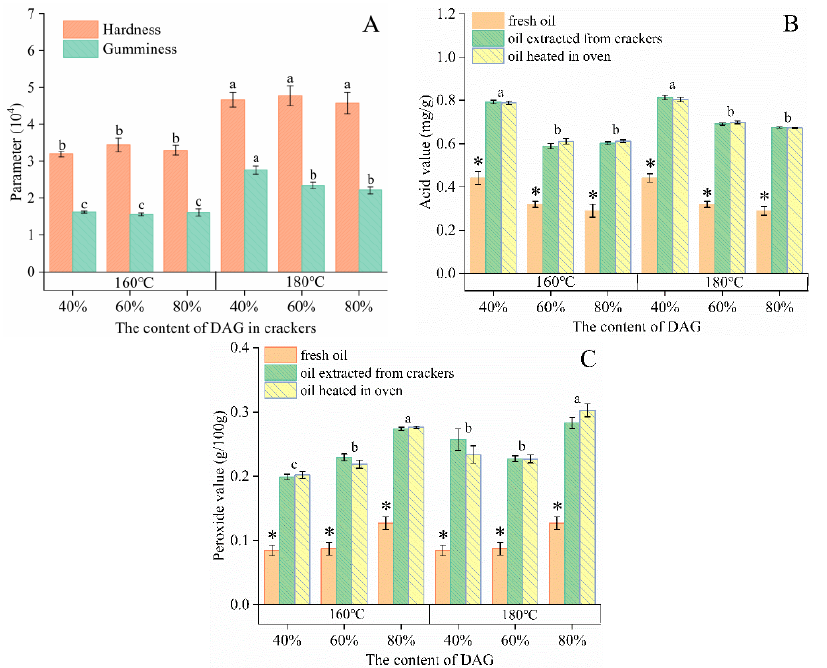
Figure 1. The texture ( A ) of crackers made with 40, 60 and 80% olive-based DAG oil; the AV ( B ) and POV ( C ) of oil at 160 and 180 °C. Different lowercase letters denote that values were significantly different ( p < 0.05), and there was no significant difference ( p > 0.05) between oil extracted from crackers and oil heated in oven. * Indicates significant difference ( p < 0.05) between fresh oil and oil extracted from crackers or oil heated in the oven. Table 1. Fatty acid composition of oil extracted from crackers and oil heated in the oven at 160 and 180 °C. Oil Extracted Fresh from Crackers in